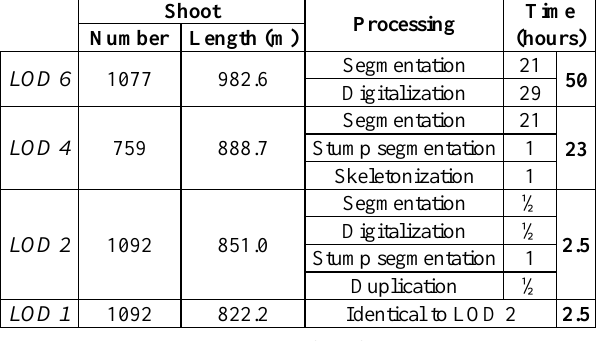
Table 8. Characteristics of the four LOD